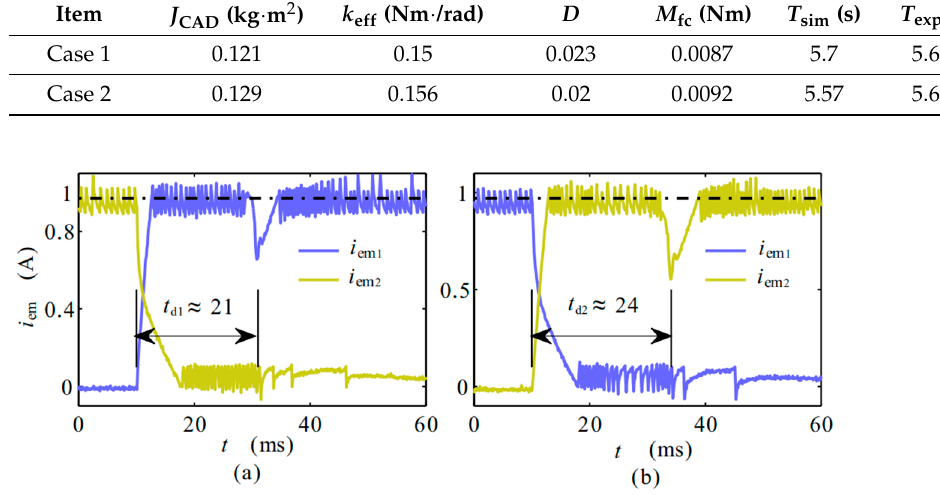
Figure 8. Current profiles showing switching delay: ( a ) electromagnet 1 powered on and electromagnet 2 off; ( b ) electromagnet 1 powered off and electromagnet 2 on. Table 1. Results of parameter identification.